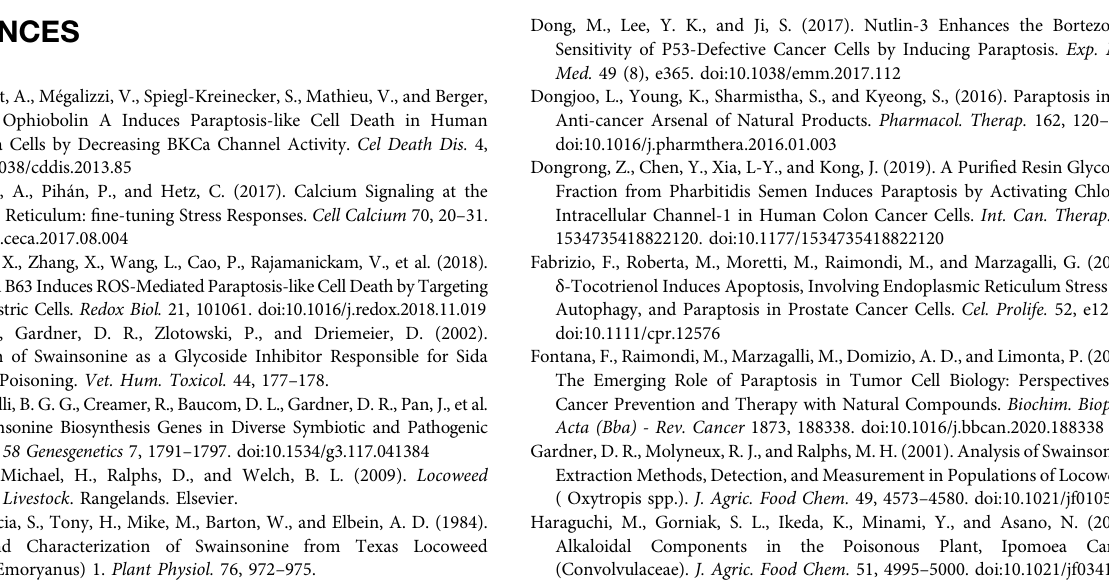
( Figure 11 ): SW cause ER stress, an increase in the intracellular Ca 2+ concentration, and damage to